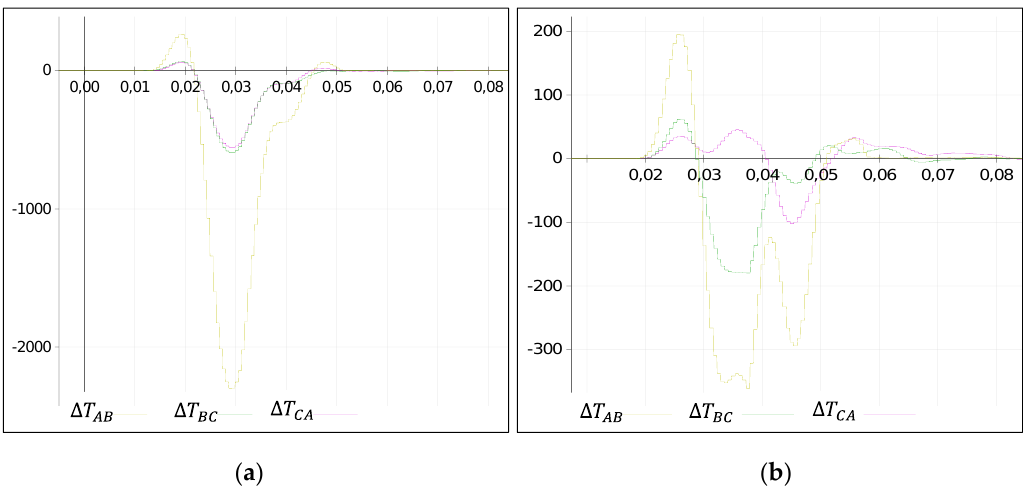
Figure 7. Instantaneous values of scalar products based on superimposed quantities theory for AB fault when current contribution comes from SG ( a ) or Type 4 WT ( b ).